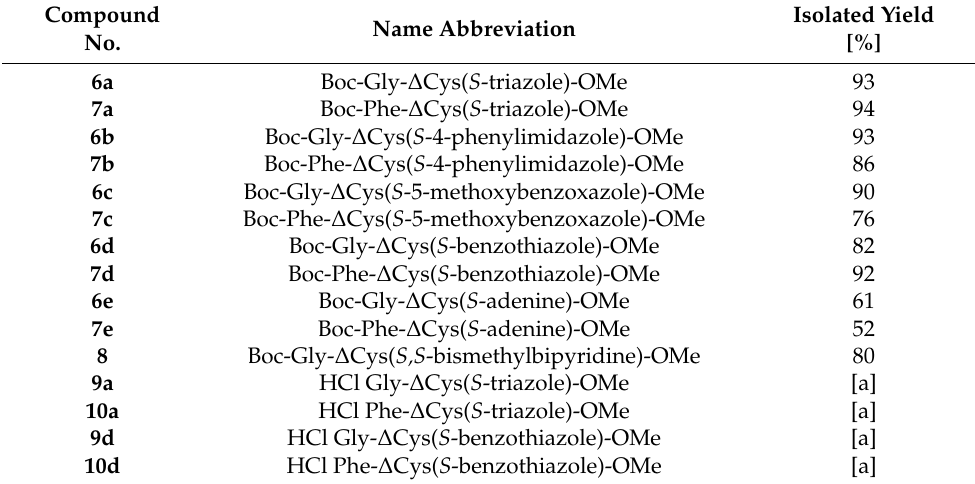
Table 1. The yield of synthesised compounds.